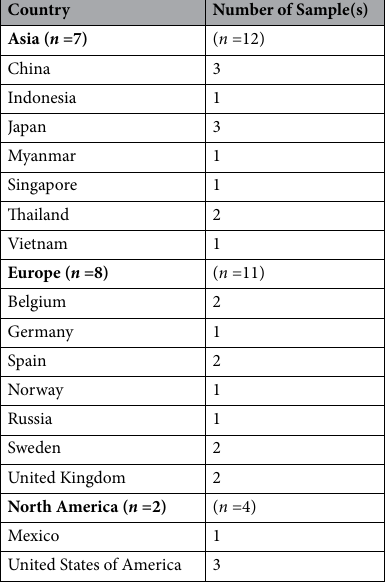
Table 1. Origin countries of cans analyzed in this